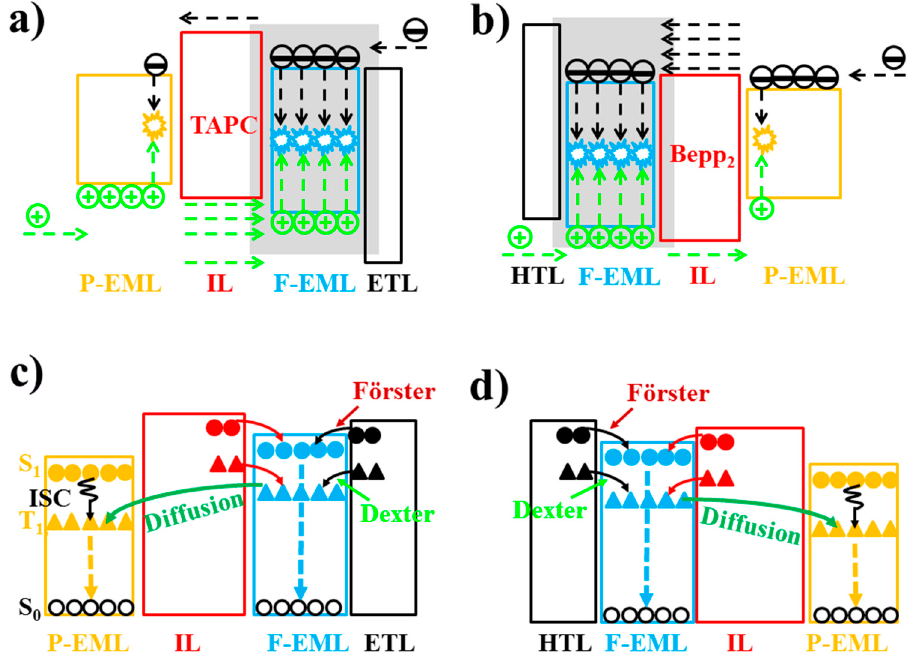
Figure 28. Diagrams of working mechanisms for different structures. The charge distribution for ( a ) devices W21 and ( b ) W22. The exciton distribution for devices ( c ) W21 and ( d ) W22. Reproduced from Reference [227].